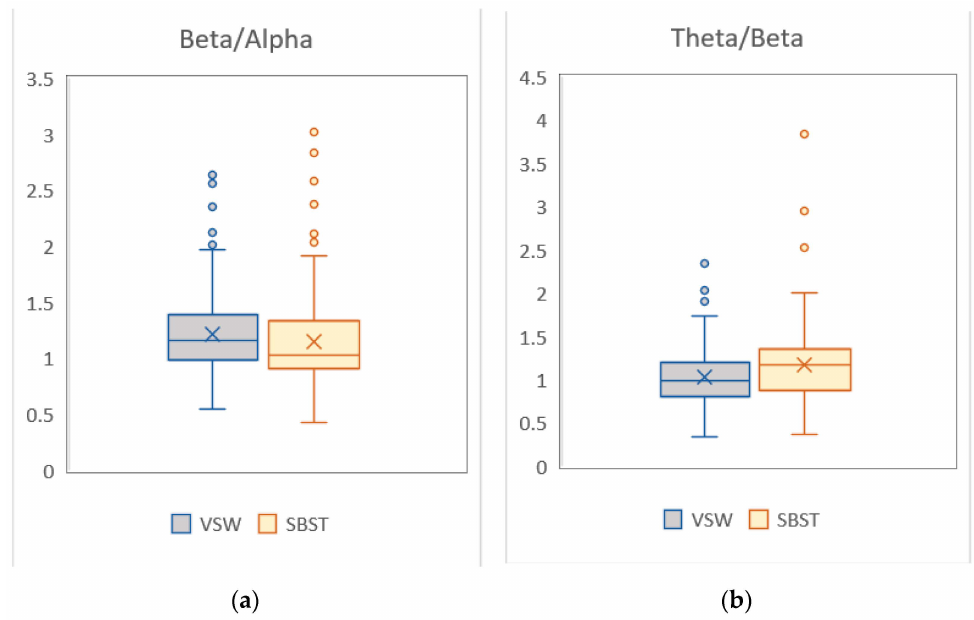
Figure 8. Attention level: ( a ) Beta/alpha ratio on VSW and SBST; ( b ) theta/beta ratio on VSW and SBST. Box plots represent distribution of the normalized power of VSW and SBST participants obtained from qEEG measurements during training. Symbol X represents